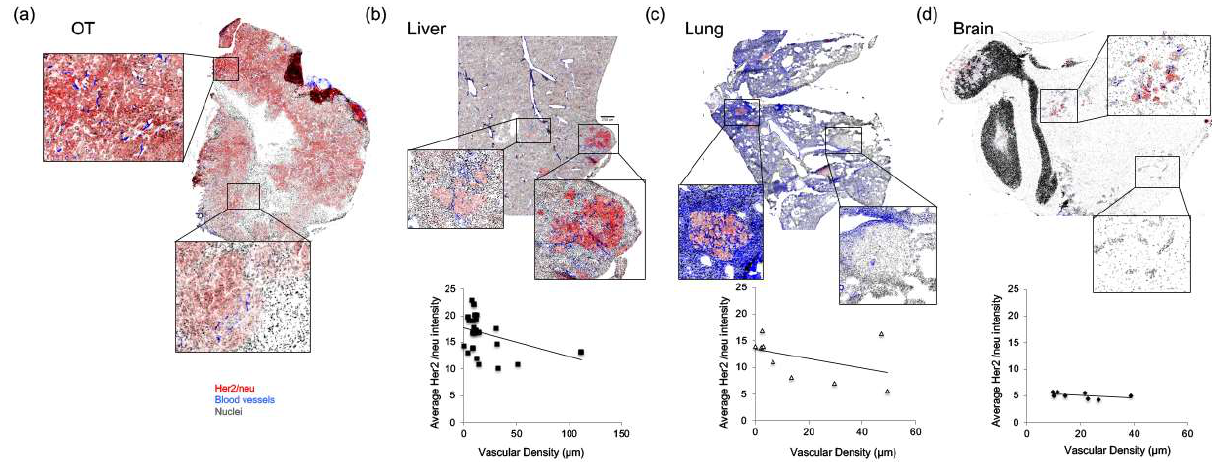
Figure 8. Tissue sections were simultaneously probed for Her2/neu expression (red) and CD31 (blue) from orthotopic tumors ( a ), liver ( b ), lung ( c ), and brain ( d ) tissues. Vascular density was quantified by calculating the average distance from each pixel to a CD31-positive object and correlated with average pixel intensity of the Her2/neu expression for liver ( b ), lung ( c ), and brain lesions ( d ).